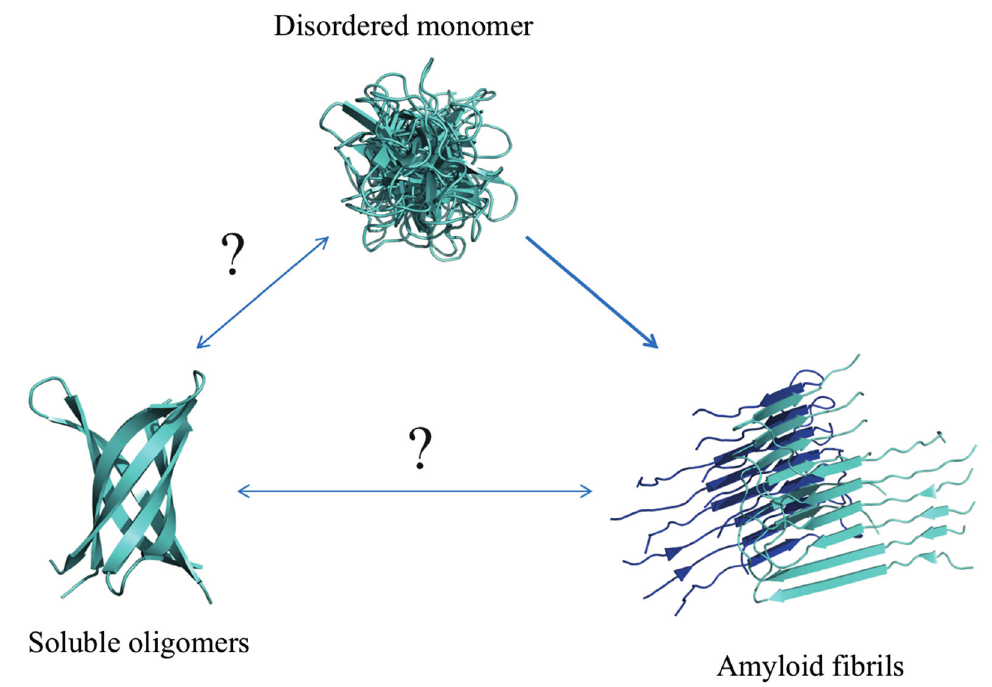
Figure 6. Schematic of the different “structures” of the A β peptide. Monomers can form fibrils, which are highly stable and rarely dissociate back into monomers, but can also form meta-stable, soluble oligomers. A hypothetical structure of a soluble oligomer is shown on the right and a NMR model of A β fibrils (PDB ID: 2lmo) is shown on the right [146]. A double-headed arrow between oligomers and fibrils is shown to illustrate a potential, but relatively unknown, interplay between the two